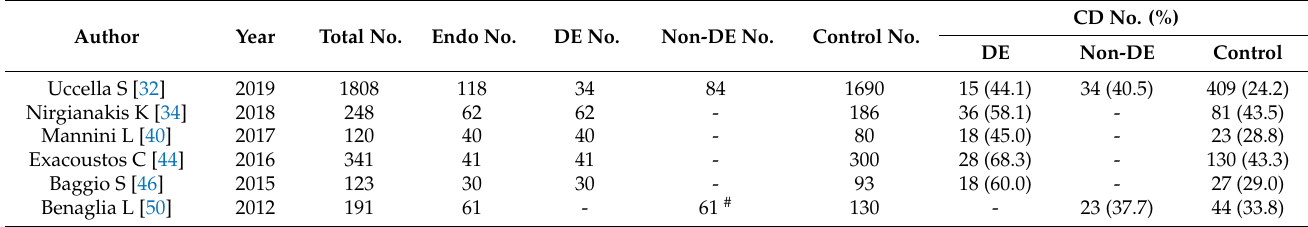
Table 3. Comparator analysis of the CD rates between women with DE and non-DE.